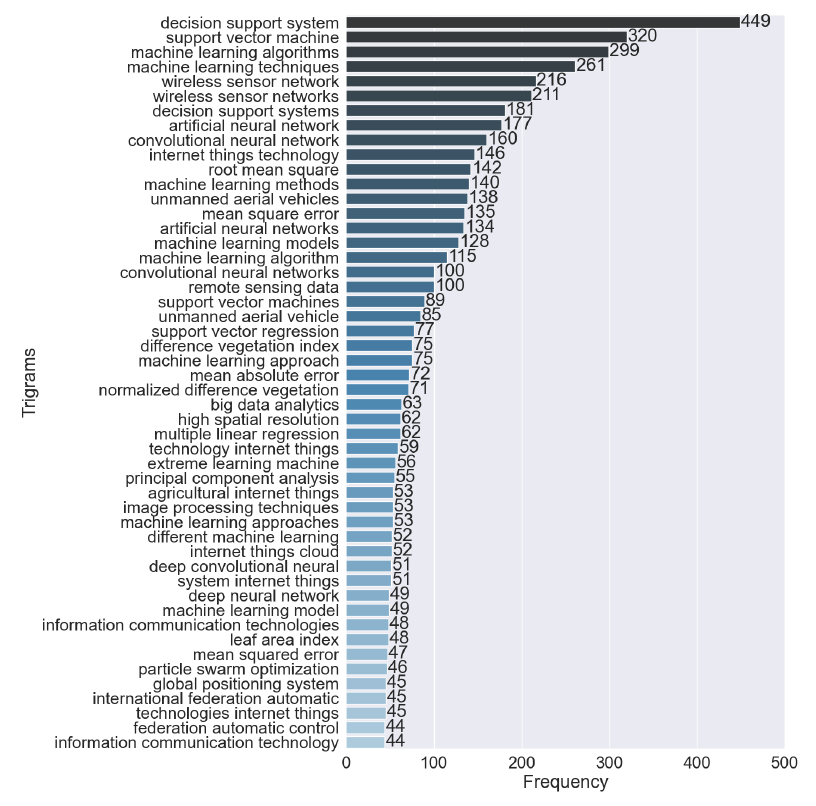
Figure 3. Top 50 of most frequent trigrams resulting from the analysis of the corpus of 8485 abstracts, using the NLP